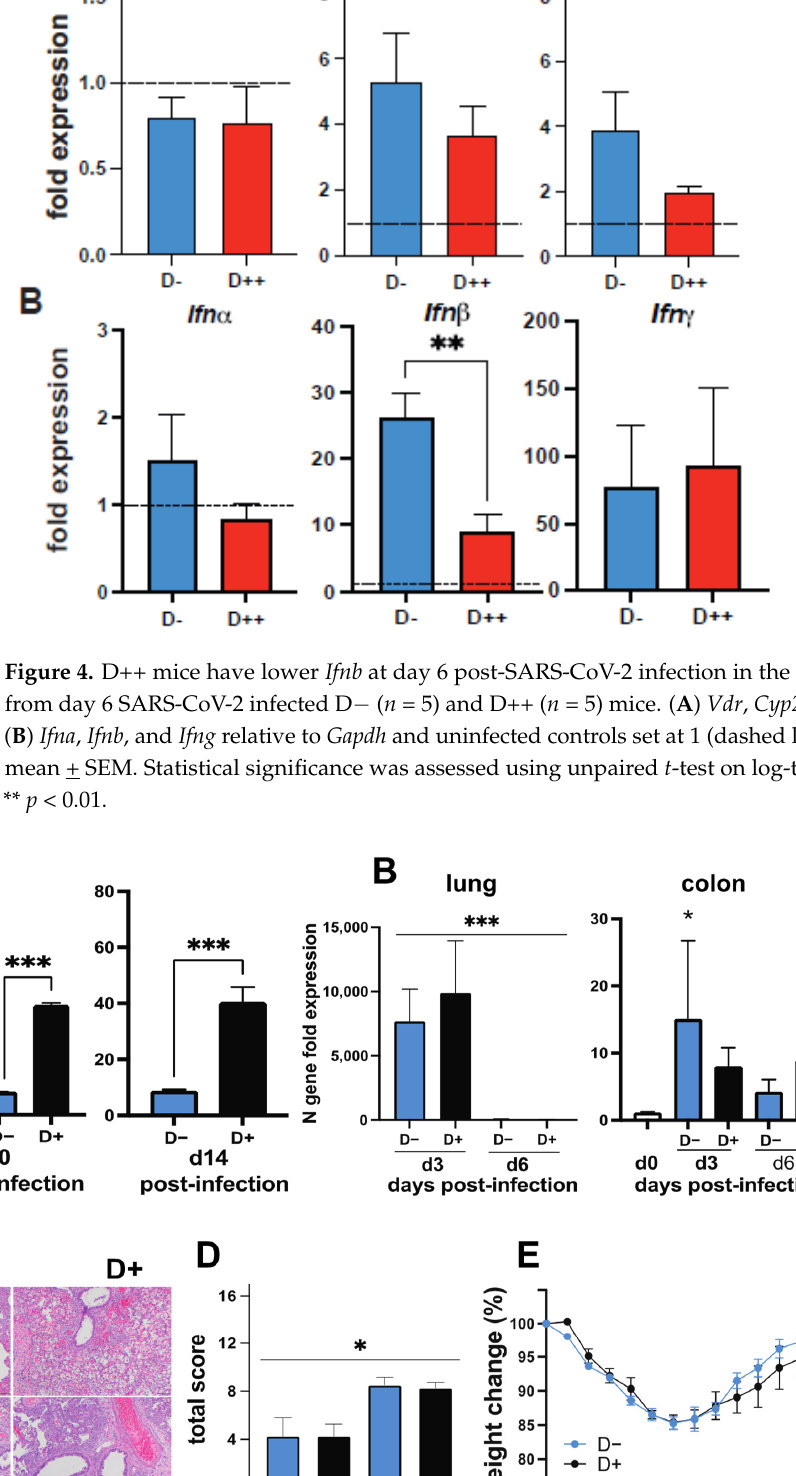
Figure 5. SARS-CoV-2 infection of hamsters. Hamsters were fed D − diets with corn oil (D − ) or 8 µ g D3/day dissolved in corn oil (D+) and then infected with SARS-CoV-2 virus. ( A ) Serum levels of 25D in chow-fed, D+, and D − fed hamsters before ( n = 2–10 hamsters/group) or from D − and D+ hamsters 14 days after ( n = 5–6 hamsters/group) SARS-CoV-2 infection. Hamsters were euthanized at day 3 and day 6 post-infection, and tissues were collected for gene expression as well as histology. ( B ) SARS-CoV-2 N gene expression in the lung and colon relative to uninfected control ( n = 4 hamsters per group and timepoint). ( C ) Representative histopathology sections of the lungs at day 3 (D − score = 6, D+ score = 4) and day 6 (D − score = 10, D+ score = 9) post-infection showed increased lymphocyte infiltration and lesions in D − and D+ hamsters at day 6 post-infection and ( D ) total histopathology scores ( n = 4 hamsters/group) were determined based on the scoring criteria outlined in Table S4. ( E ) Change in body weight following infection with SARS-CoV-2 ( n = 5–6 hamsters/group). Values are the mean ± SEM. Statistical significance was assessed using Kruskal–Wallis test with Dunn’s multiple comparison (day 0) and unpaired t-test (day 14) for ( A ), one-way ANOVA with Bonferroni multiple comparison test on log-transformed expression values for ( B ), one-way ANOVA for ( D ), and two-way ANOVA with Bonferroni multiple comparison test for ( E ). * p < 0.05 and *** p < 0.001. 4. Discussion Vitamin D deficiency resulted in lung inflammation in the absence of infection. In- fected D − mice had more severe lung inflammation and respiratory symptoms than D+ or D++ mice when infected with either H1N1 influenza or SARS-CoV-2. The data point to shared effects of vitamin D to control inflammation in the lung following influenza or coronavirus infection. D − mice had significantly more inflammation than D+ mice follow- ing H1N1 influenza infection (Figure 1). High-dose vitamin D3 treatment (D++) resulted in some protection of mice from SARS-CoV-2 (Figure 3). In addition, 1,25D treatment